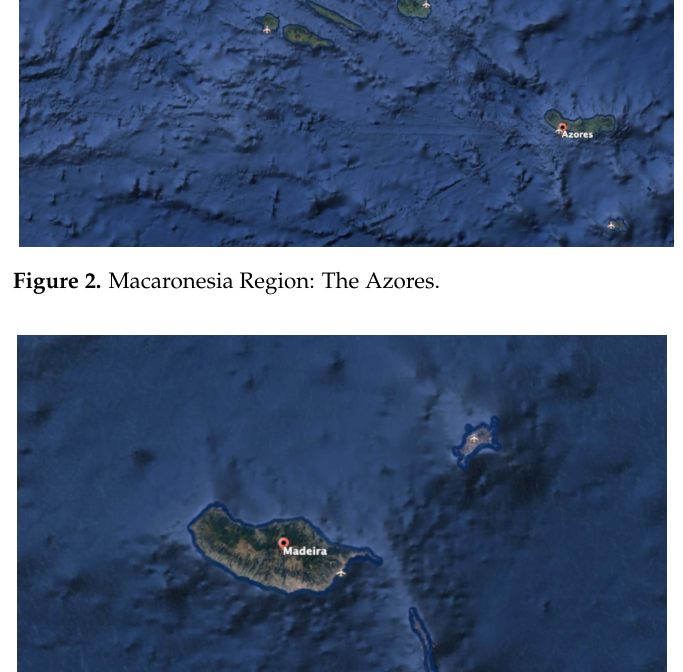
Figure 3. Macaronesia Region: Madeira.